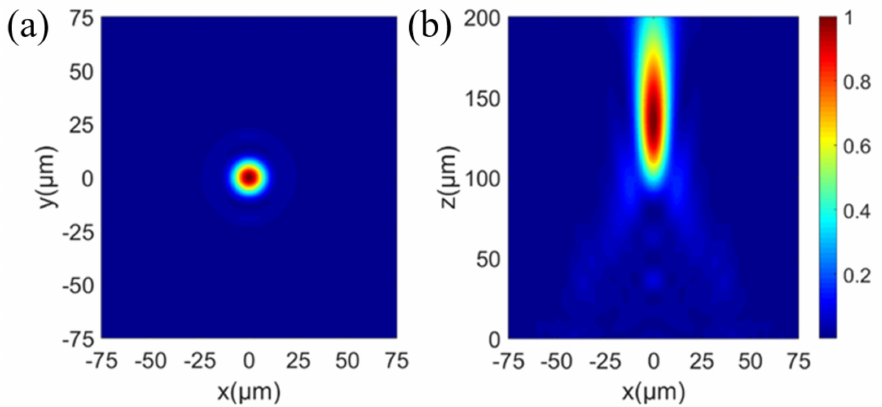
Figure 2. The normalized distribution of the square of the electric field intensity of the PIM: ( a ) X − Y plane; ( b ) X − Z plane.